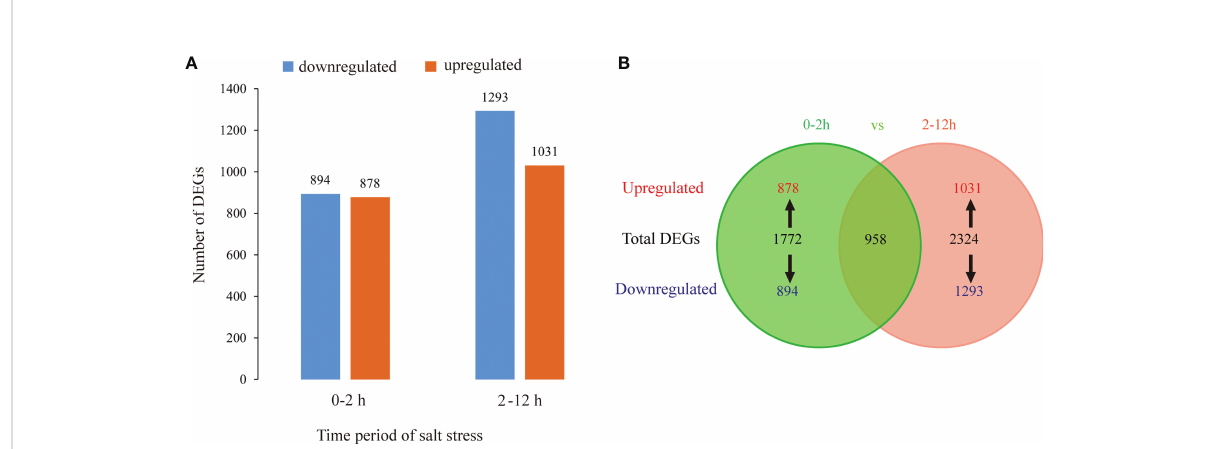
FIGURE 6 DEGs between L. pumilum bulb samples at different time points (0, 2, and 12 h) during salt stress. (A) Number of upregulated or downregulated DEGs in pairwise comparisons, (B) Venn diagram showing number of DEGs in different